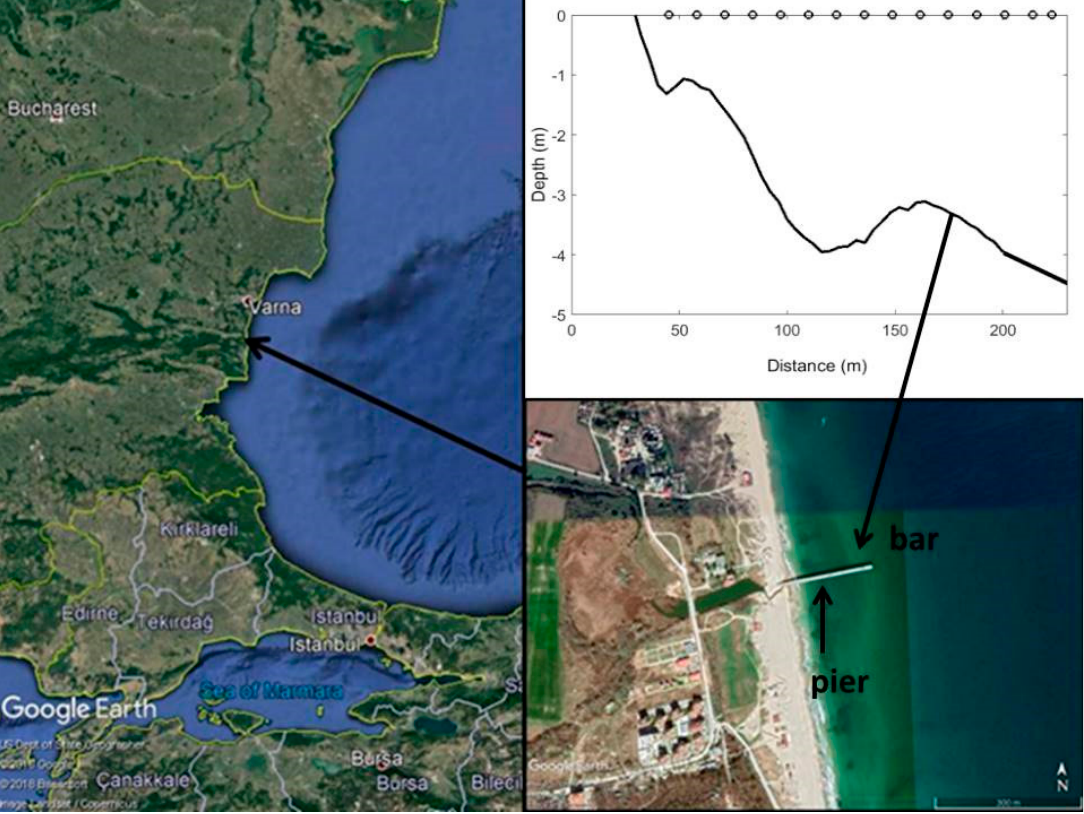
Figure 1. Location of the study site, sea bottom profile on 27 September 2007 and positions of wave gauges during the field experiment.